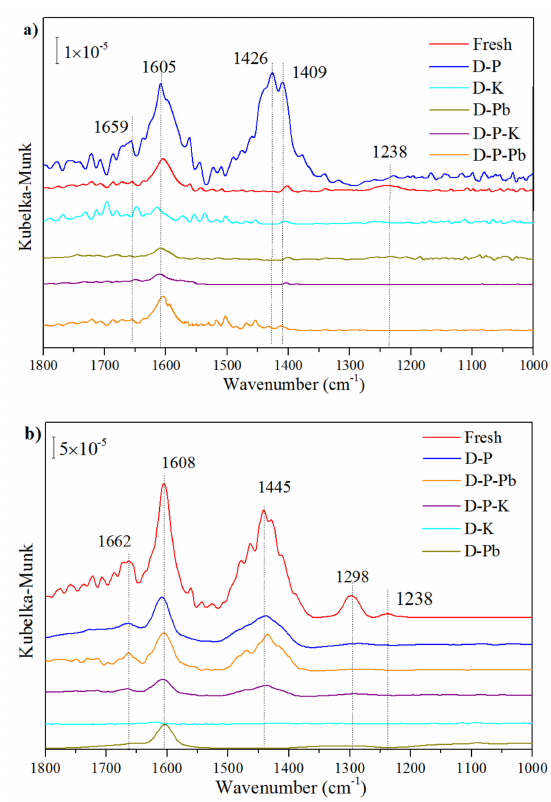
Figure 4. In situ DRIFTS spectra of NH 3 adsorption on fresh and poisoned catalysts at 350 ◦ C ( a ) and 200 ◦ C ( b ) for 30